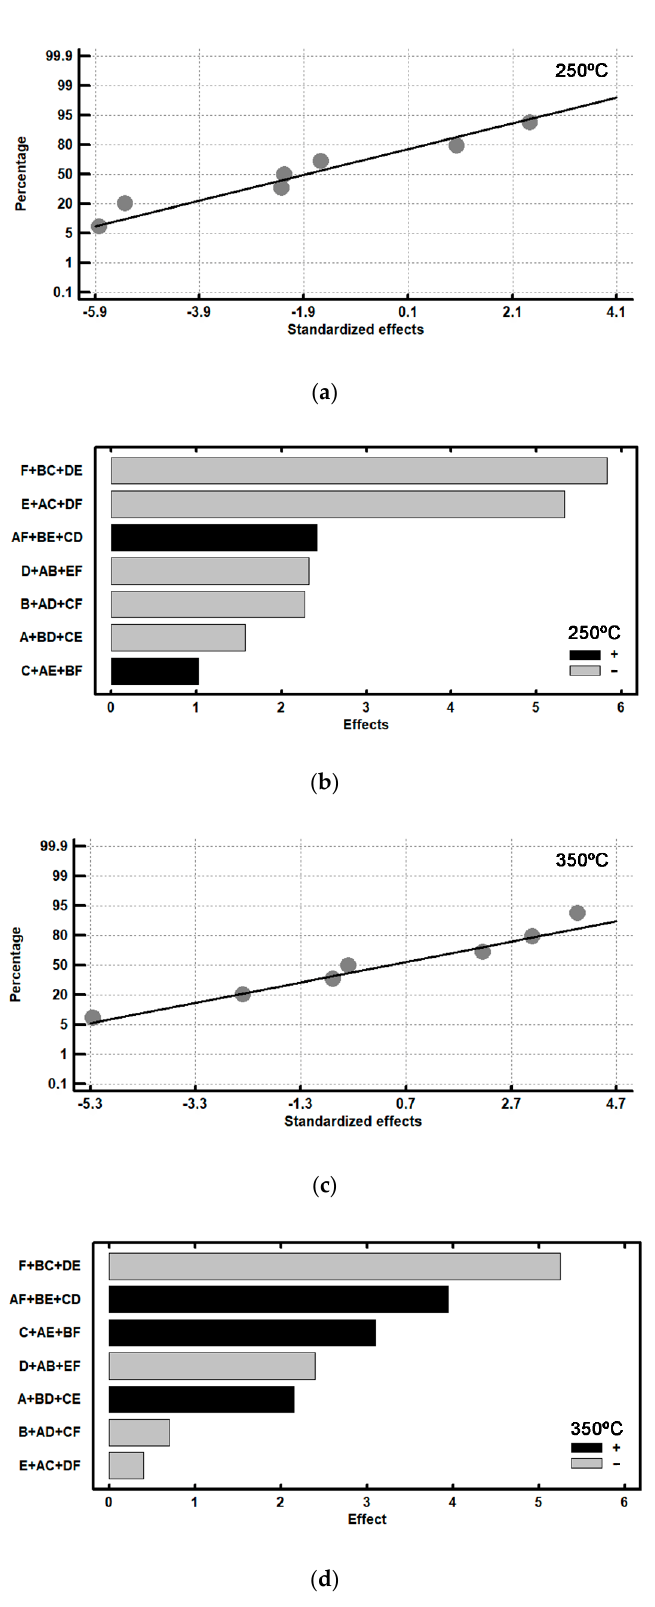
Figure 7. Graphic representation of wear in zone III. ( a ) 250 ◦ C, representation of effects on a normal probability paper. ( b ) 250 ◦ C, representation of effects in a Pareto diagram; ( c ) 350 ◦ C, representation of effects on a normal probability paper; ( d ) 350 ◦ C, representation of effects in a Pareto